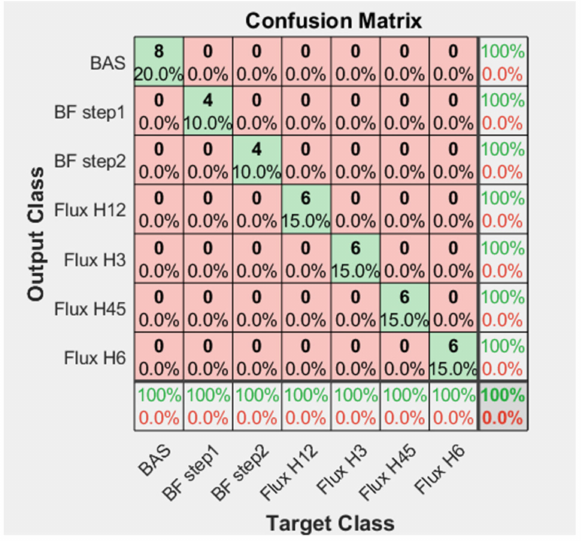
Figure 10. Confusion matrix (test set) for the seven classes of radial flux